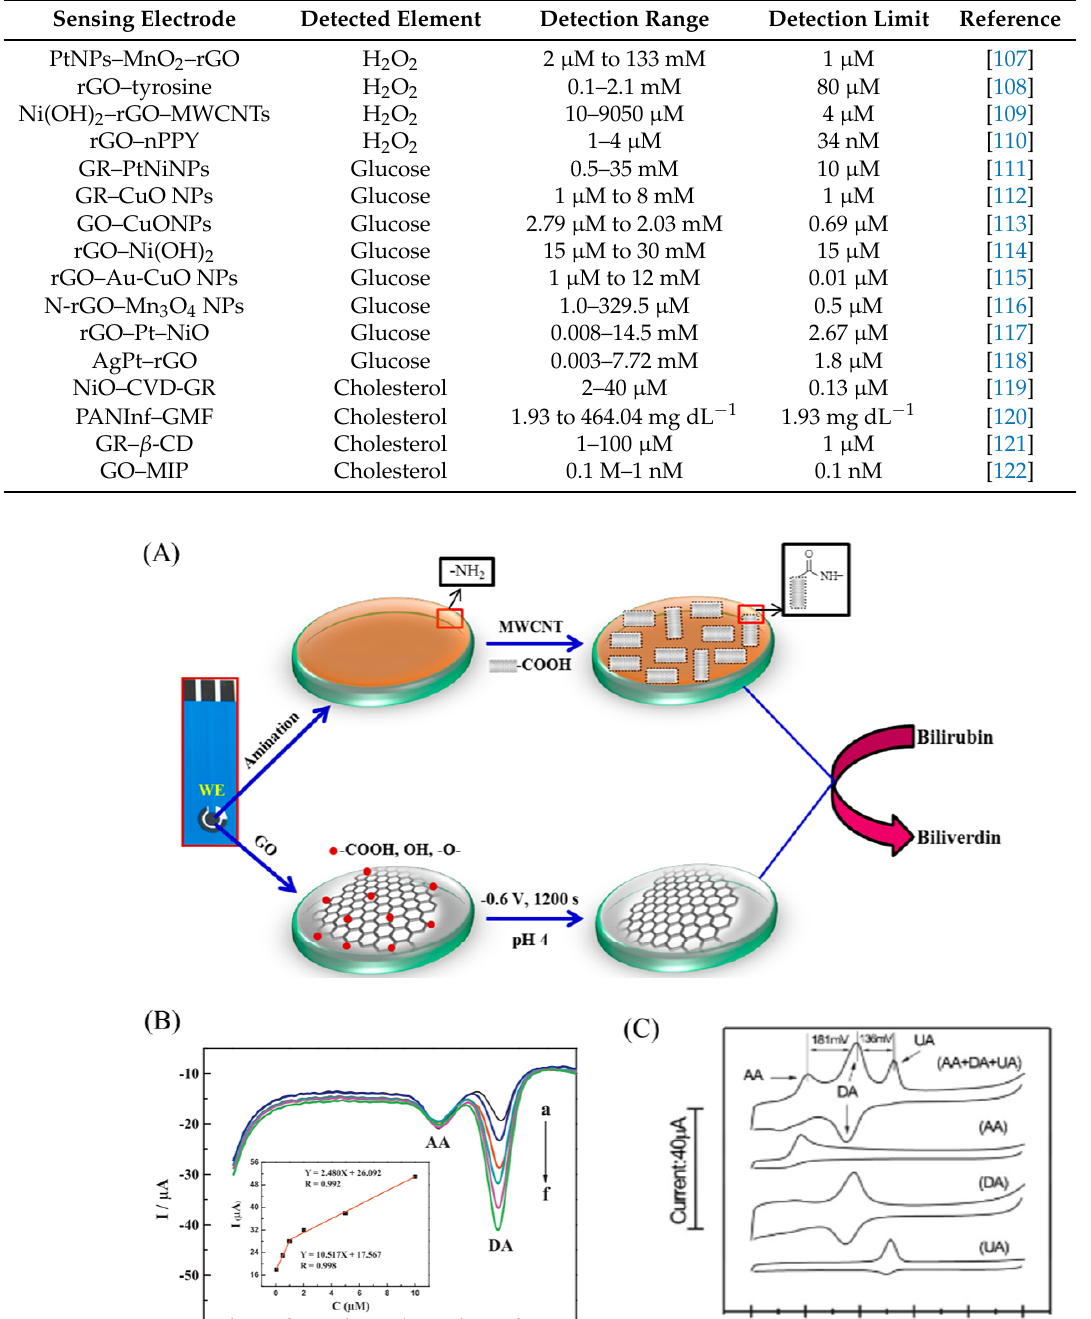
Table 2. Performance of non-enzymatic biosensors based on graphene based nanomaterials. Sensing Electrode